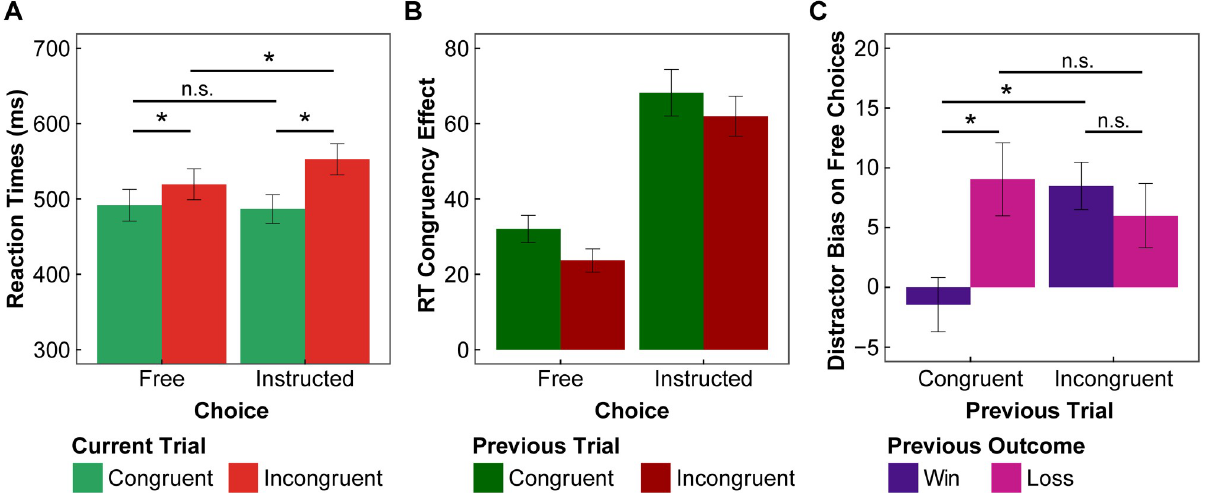
Fig 2. Influence of conflict at the decision stage. A. Average RTs as a function of choice and current trial distractor-action congruency. B. Average conflict effects on RTs (incongruent minus congruent) as a function of choice and previous trial congruency. C. Average distractor bias effect on free choices (percentage of congruent minus incongruent choices) as a function of previous trial congruency and outcome (win/loss). Error bars represent the standard error of the mean. � p < .05, n.s. = non significant.